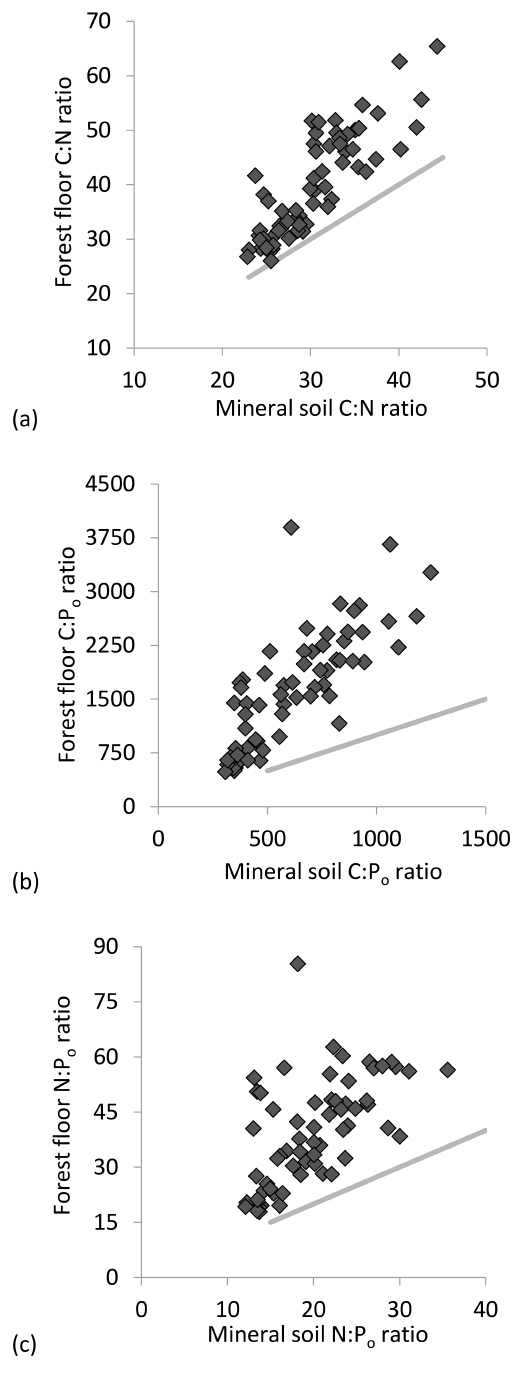
Figure 3. Correlation in resource stoichiometry for (a) C:N molar ratio, (b) C:P o molar ratio and (c) N:P o molar ratio between min- eral soil and forest floor substrates. A 1 : 1 relationship is depicted by the gray lines.